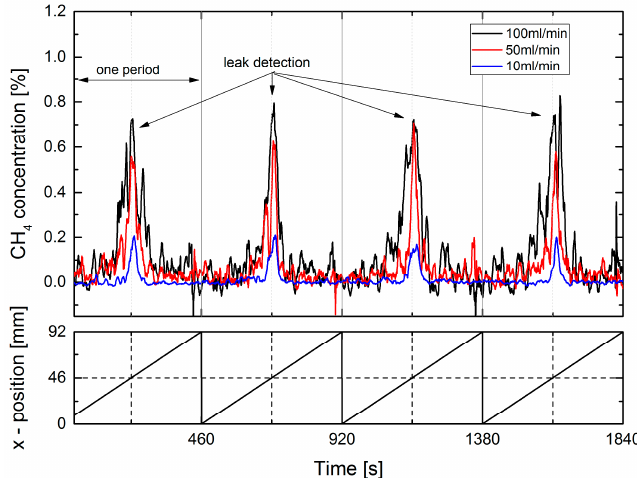
Figure 11. Dynamic standoff measurement of 1% CH 4 in N 2 with fluxes of 100, 50, and 10 mL/min. The distance between laser and leak plate was 55 cm. The leak plate was horizontally moved by a sliding stage with a speed of 0.2 mm/s in a sawtooth manner, as indicated by the lower figure. The leak position is at 46 mm